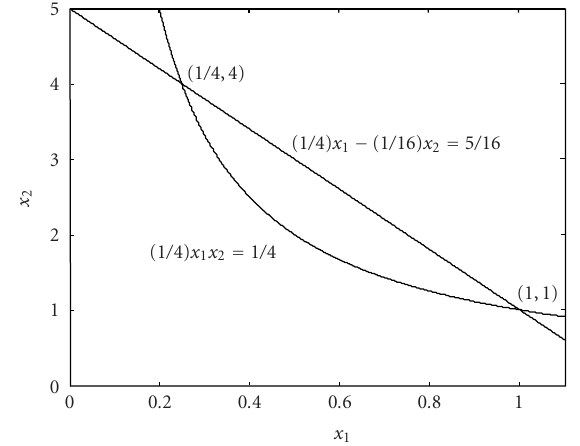
Figure 4: Intersection in ( x 1 , x 2 ) space for a 1 = 5 / 16 and a 2 = 1 / 4.